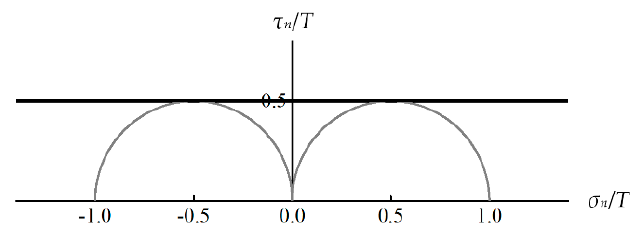
Figure 8. Failure envelope of typical ductile material. C / T = 1, θ T = 45 ◦ , and θ C = 45 ◦ .